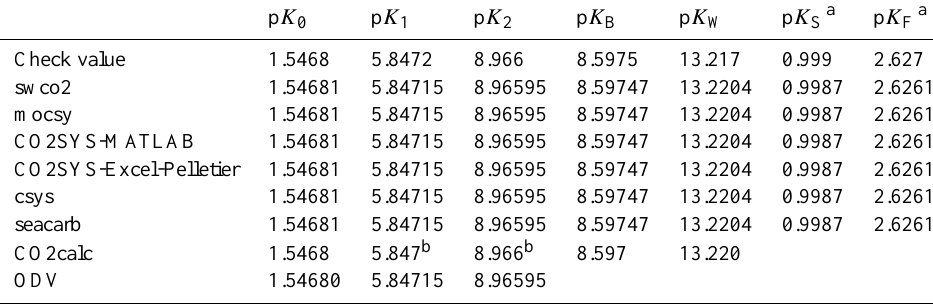
Table 12. Check values vs. computed equilibrium constants (p K s) at T = 25 ◦ C, S = 35, and P = 0. p K 0 p K 1 p K 2 p K B p K W p K S a p K F a Check